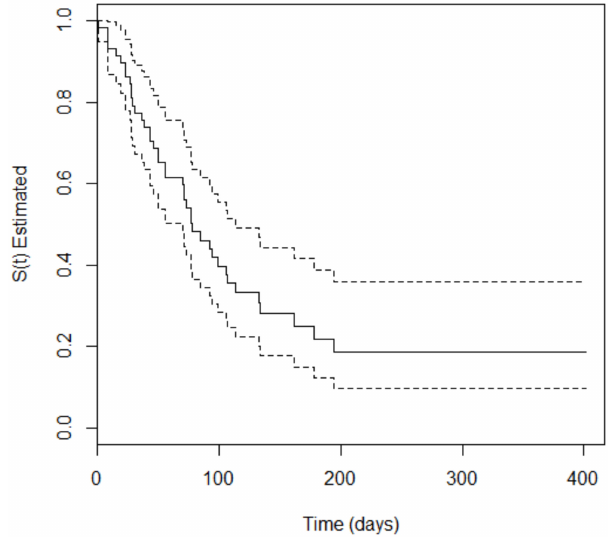
Figure 2. Kaplan–Meier curve (solid line) with 95% confidence interval (dotted line) corresponding to patients with solid